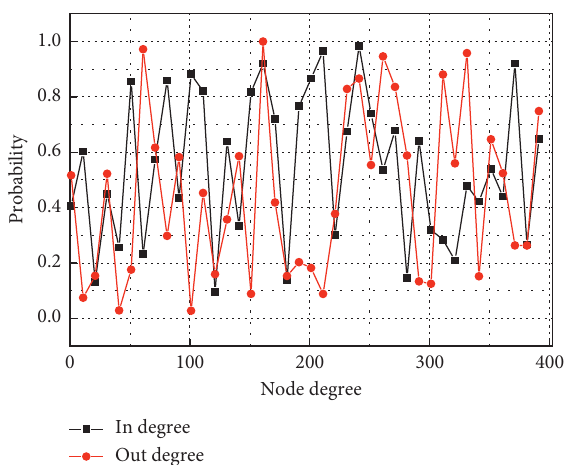
Figure 7: Probability distribution of node degree in the financial